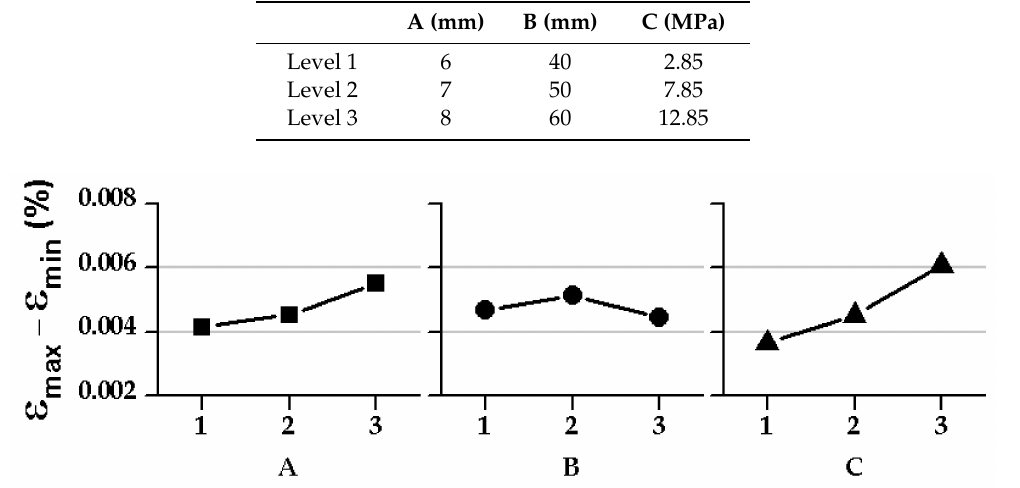
Table 4. Modified factor levels for determining the global minimum.